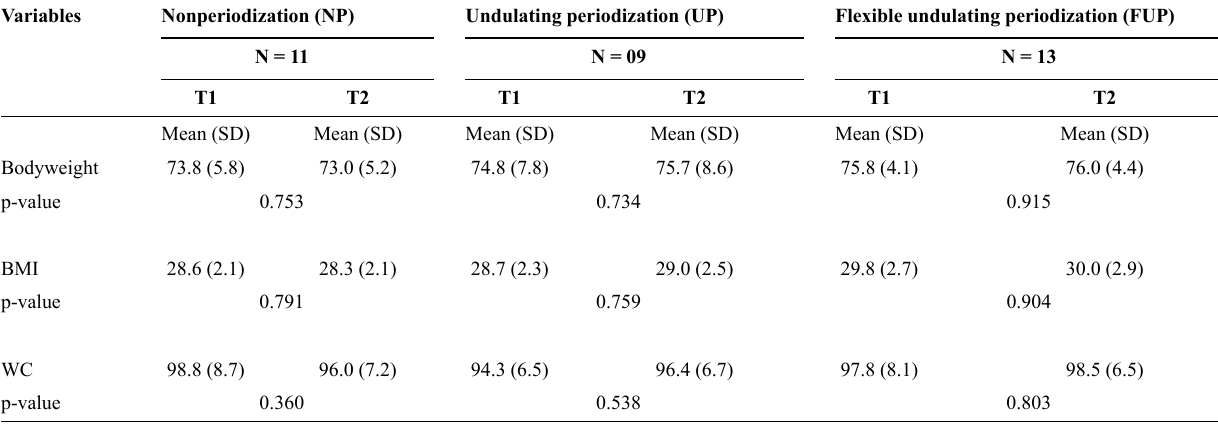
Table 1 - Distribution of the participants regarding weight variables, by physical training group and evaluation time.